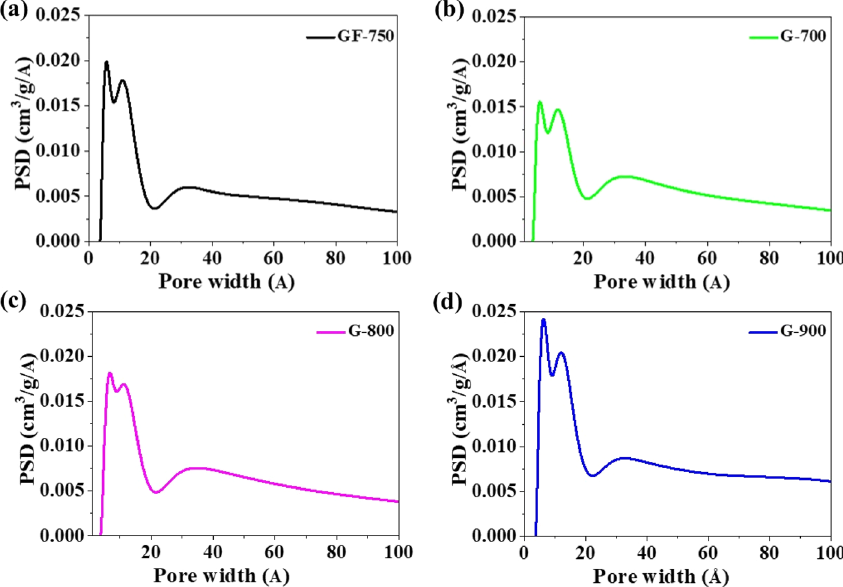
Figure 1. Pore size distribution obtained from adsorption branches of N 2 used nonlocalized density functional theory (NLDFT) method of samples ( a ) GF-750, ( b ) G-700, ( c ) G-800 and ( d ) G-900.